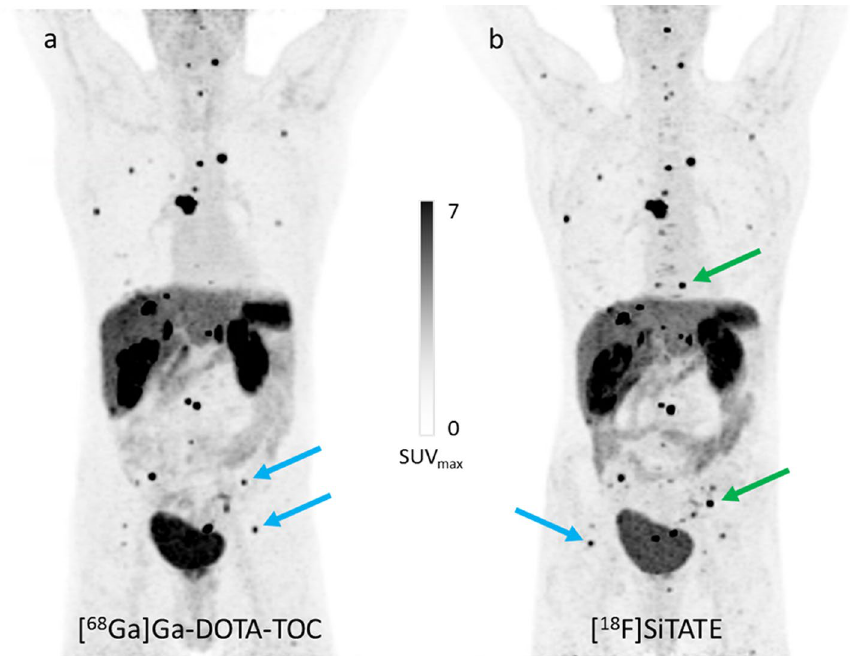
Fig. 1 Maximum intensity projection (MIP) of [ 68 Ga]Ga-DOTA-TOC ( a ) and [ 18 F]SiTATE ( b ) PET of a 64-year-old male patient with Ileum NET (G1). The patient received Sandostatin LAR therapy between both PET scans (377 days between first and second scan), but the disease was considered stable. Blue arrows indicate comparably increased uptake of [ 18 F]SiTATE compared to [ 68 Ga]Ga-DOTA-TOC or vice versa. Green arrows indicate some of the lesions, which were detected in the [ 18 F]SiTATE PET, but not in the [ 68 Ga]Ga-DOTA-TOC